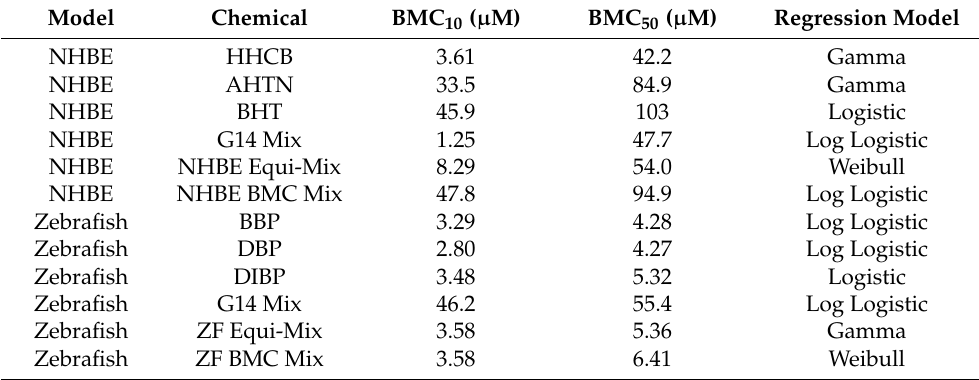
Figure 2. Concentration–response curves of HHCB, AHTN, BHT, BMC-anchored (NHBE BMC Mix), and equimolar (NHBE Equi-Mix) mixtures in NHBE. Table 7. BMC values for mixtures and their bioactive components across both biological